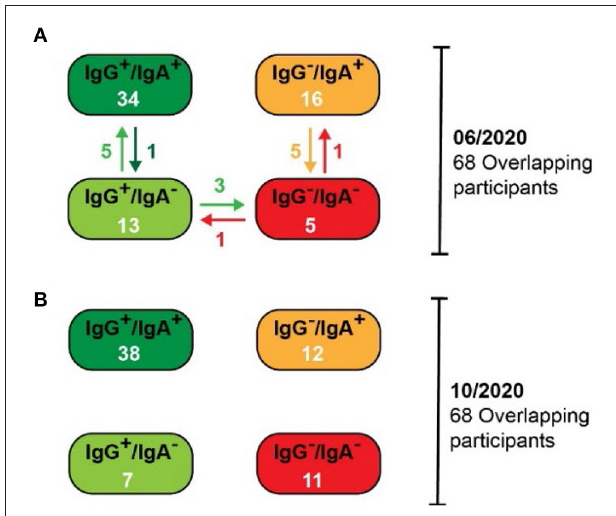
FIGURE 2 | Alterations in the SARS-CoV-2-specific antibody prevalence between the pilot (06/2020) and the follow-up (10/2020) studies. (A) Antibody prevalence in the pilot study. Specific changes are indicated with arrows. (B) Antibody prevalence in the follow-up study.